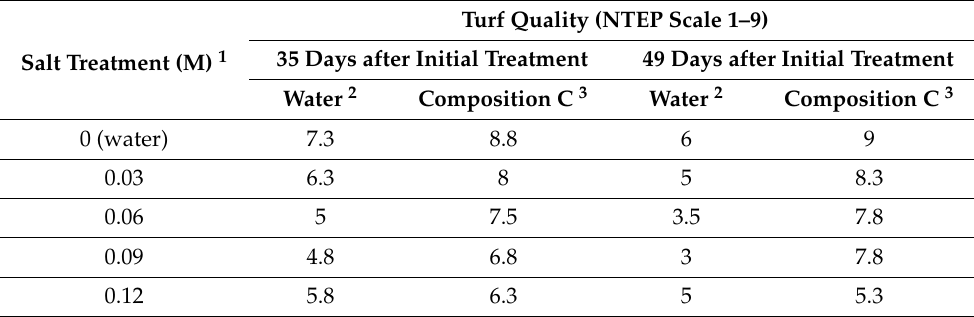
Table 4. Conditions of different plants’ treatment under salt stress: the case of turf grass [9].